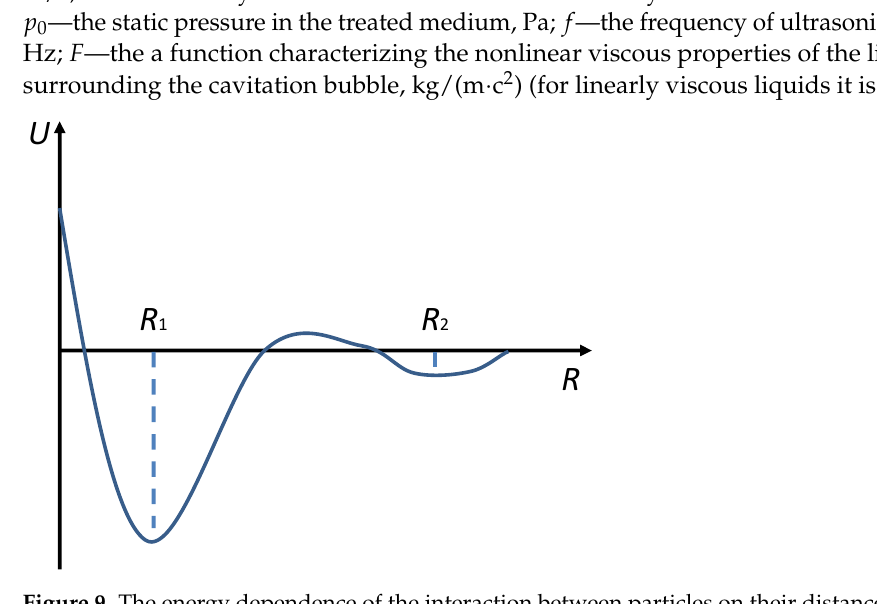
Figure 9. The energy dependence of the interaction between particles on their distance. U—energy of interaction between particles; R 1 —distance of the nearest potential holes (near coagulation); R 2 —distance of the farther potential holes (distant coagulation).